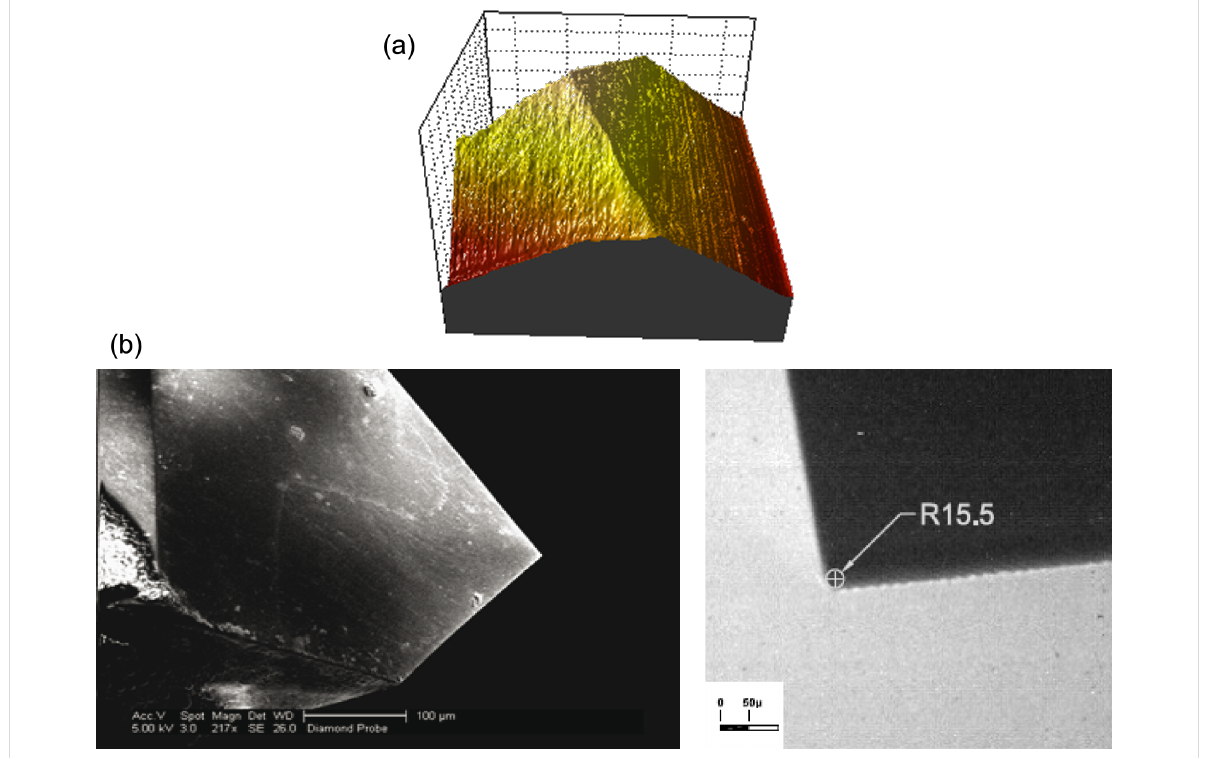
Figure 10: Images of cube-corner diamond tip used in nanoindentation experiments. (a) A 3D representation of AFM scan for the cube-corner diamond tip used in nanoindentation experiments. (b) SEM and TEM images of the diamond tip. The tip radius is measured as 15.5 nm.